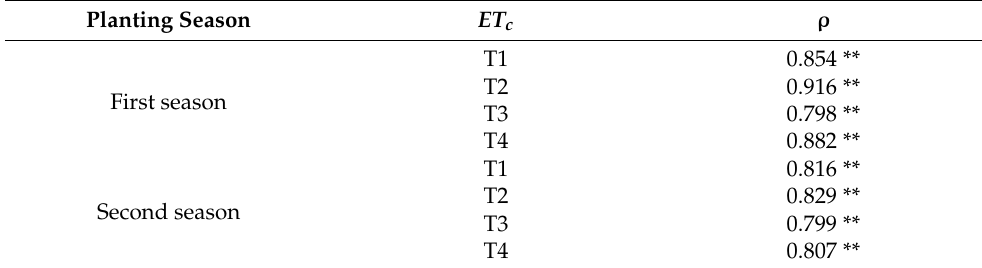
Table 5. Correlation analysis between ET c and